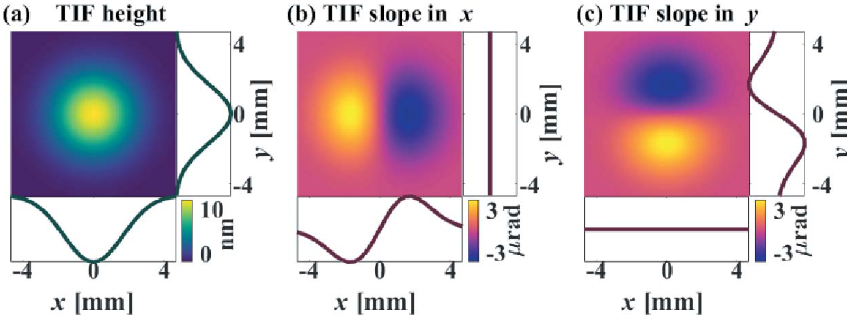
Figure 2 Height ( a ), slope in x ( b ) and slope in y ( c ) of the analytical Gaussian TIF with FWHM = 5 mm used in the